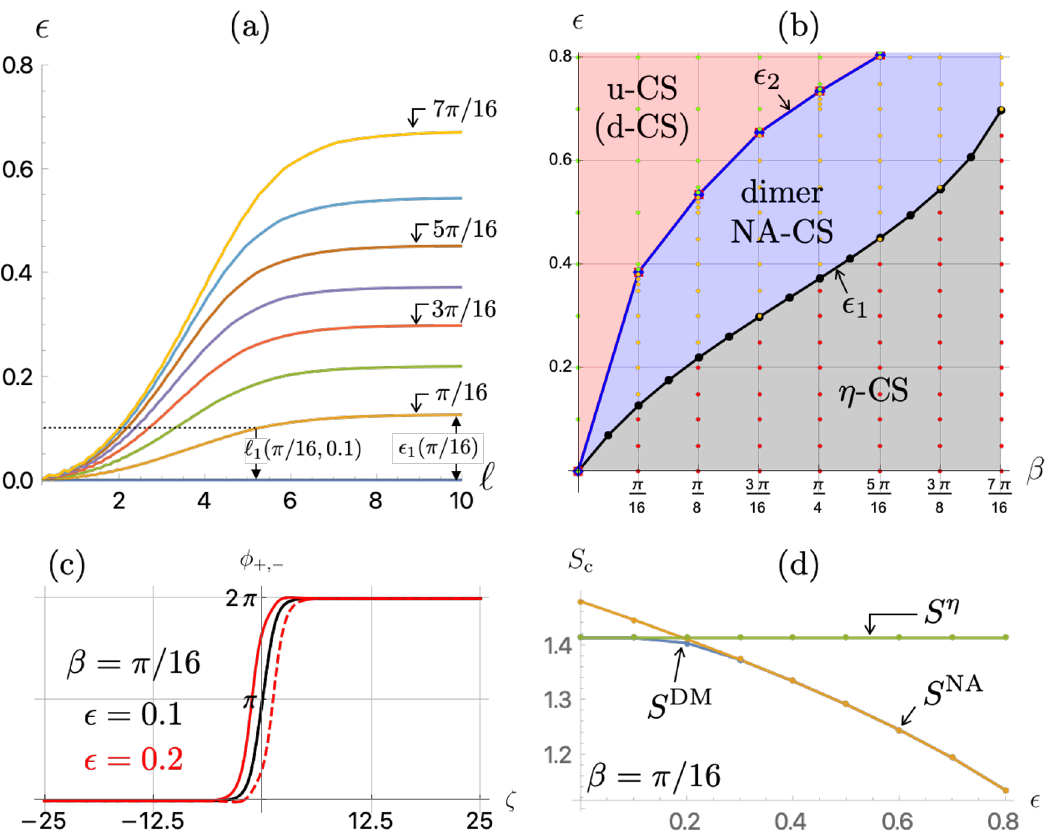
Figure 2 . (a) Linear stability of the η -CSL in the ‘ - (cid:15) plane. It is unstable above each curve with β = 0 – 7 π/ 16 . (b) Phase diagram of a single CS. The black and blue dotted lines show (cid:15) 1 and (cid:15) 2 , respectively. (c) The solid (dashed) curve corresponds to φ + ( φ − ). The black (red) curves are as follows: For η -CS of (cid:15) = 0 . 1 (dimer NA-CS of (cid:15) = 0 . 2 ). β = π/ 16 . (d) Three critical velocities S η , S NA , and S DM are shown for β = π/ 16